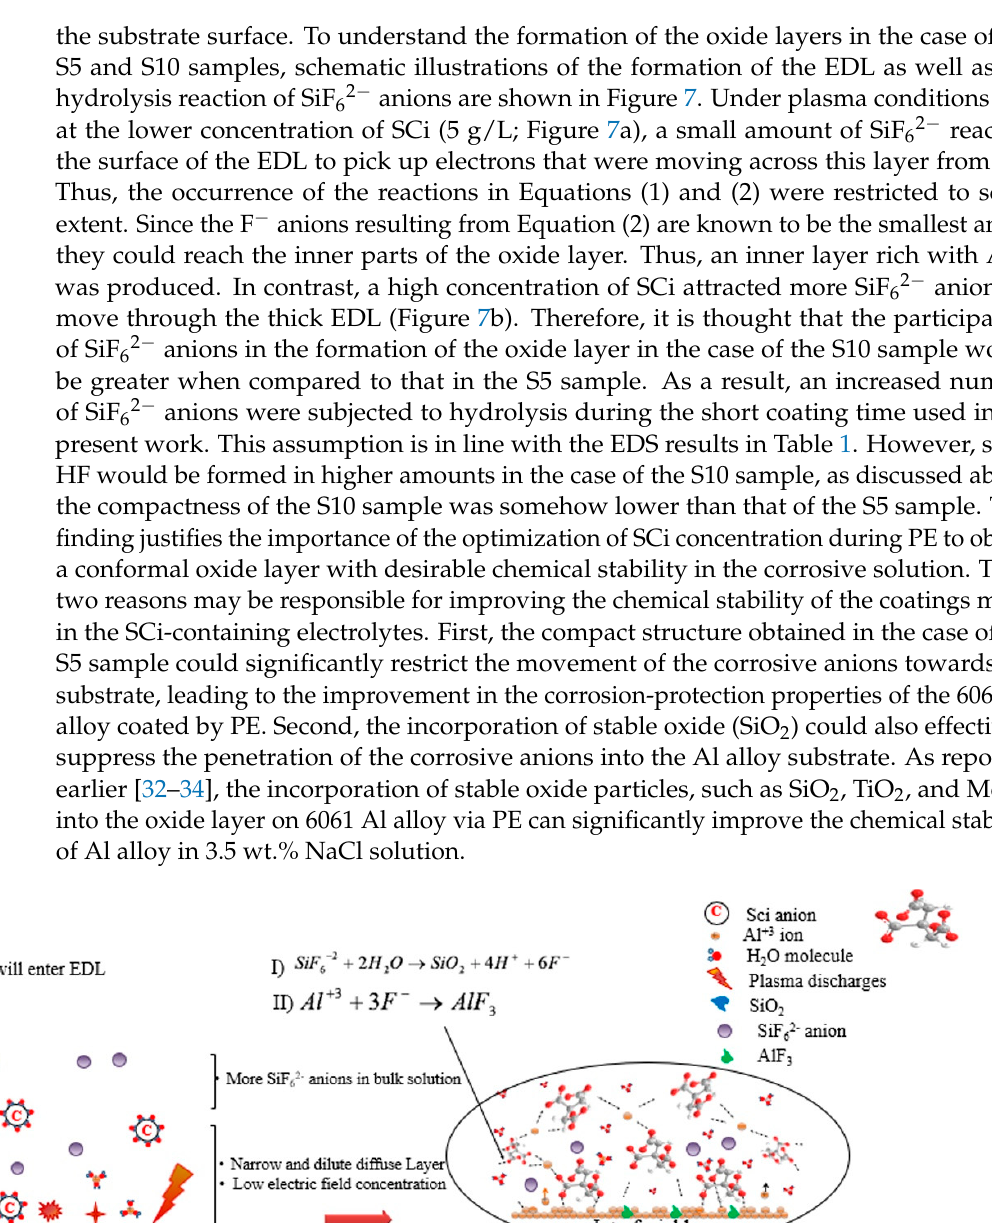
Figure 7. Schematic illustration showing the formation of the EDL as well as the hydrolysis reaction of SiF 62 − anions on the surface of the ( a ) S5 sample and ( b ) S10 sample. 4. Conclusions In this work, we exploited the hydrolysis reaction of SiF 62 − anions induced by SCi in addition to controlling the porosity in the plasma inorganic layers through a novel process that involved regulating the incorporation of silicon and fluorine-based compounds. The results of the present study can be summarized as follows: (1) PE treatment in solutions containing SCi gave rise to relatively compact structures with minimum sizes of micropores. (2) A thick EDL tended to be formed on the substrate surface during the initial stage of the PE process conducted in a solution containing SCi additive. (3) The hydrolysis of SiF 62 − anions transferred through the EDL was found to be affected by the thickness of the EDL. (4) A controlled hydrolysis of SiF 62 − anions was found in the case of the S5 sample treated in a solution containing 5 g/L of SCi, which resulted in the formation of a very dense oxide layer on its surface.